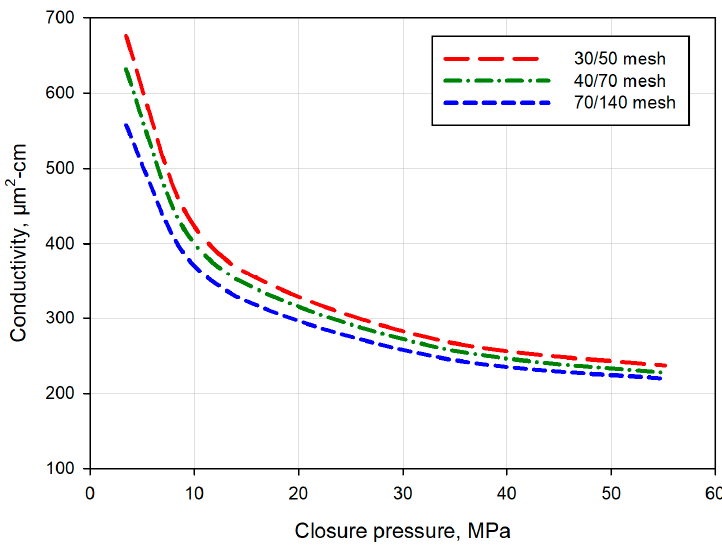
Figure 11. Conductivity evolution of H-shaped intersecting pattern fractures with different sizes of proppants.